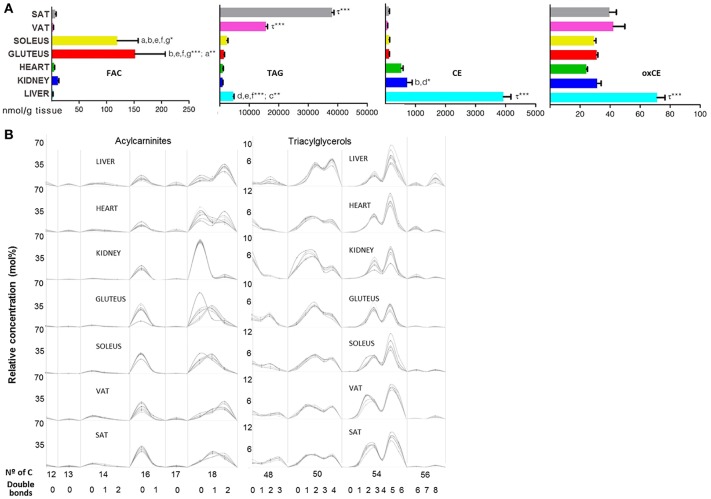
Bioenergetic lipid species within mammalian tissues detected by targeted lipidomic analysis. (A) Concentration of FAC, TAG, CE, and oxCE. Values are expressed as mean ± SEM from 8 to 10 animals. Statistical analysis was one-way anova and post-hoc Tukey significance is represented in the bar chart, meaning a significantly different respect to SAT, b respect to VAT, c respect to soleus, d respect to gluteus, e respect to heart and f respect to kidney, g respect to liver, τ respect to all. *p < 0.05, **p < 0.01, and ***p < 0.001. (B) Relative concentration of lipids normalized per sample to the total abundance within this lipid class to obtain molar fractions. Each solid line indicated tissue from an individual rat. Gray vertical lines separate lipids by total number of acyl chain carbons. The number of double bonds is indicated below within each group.